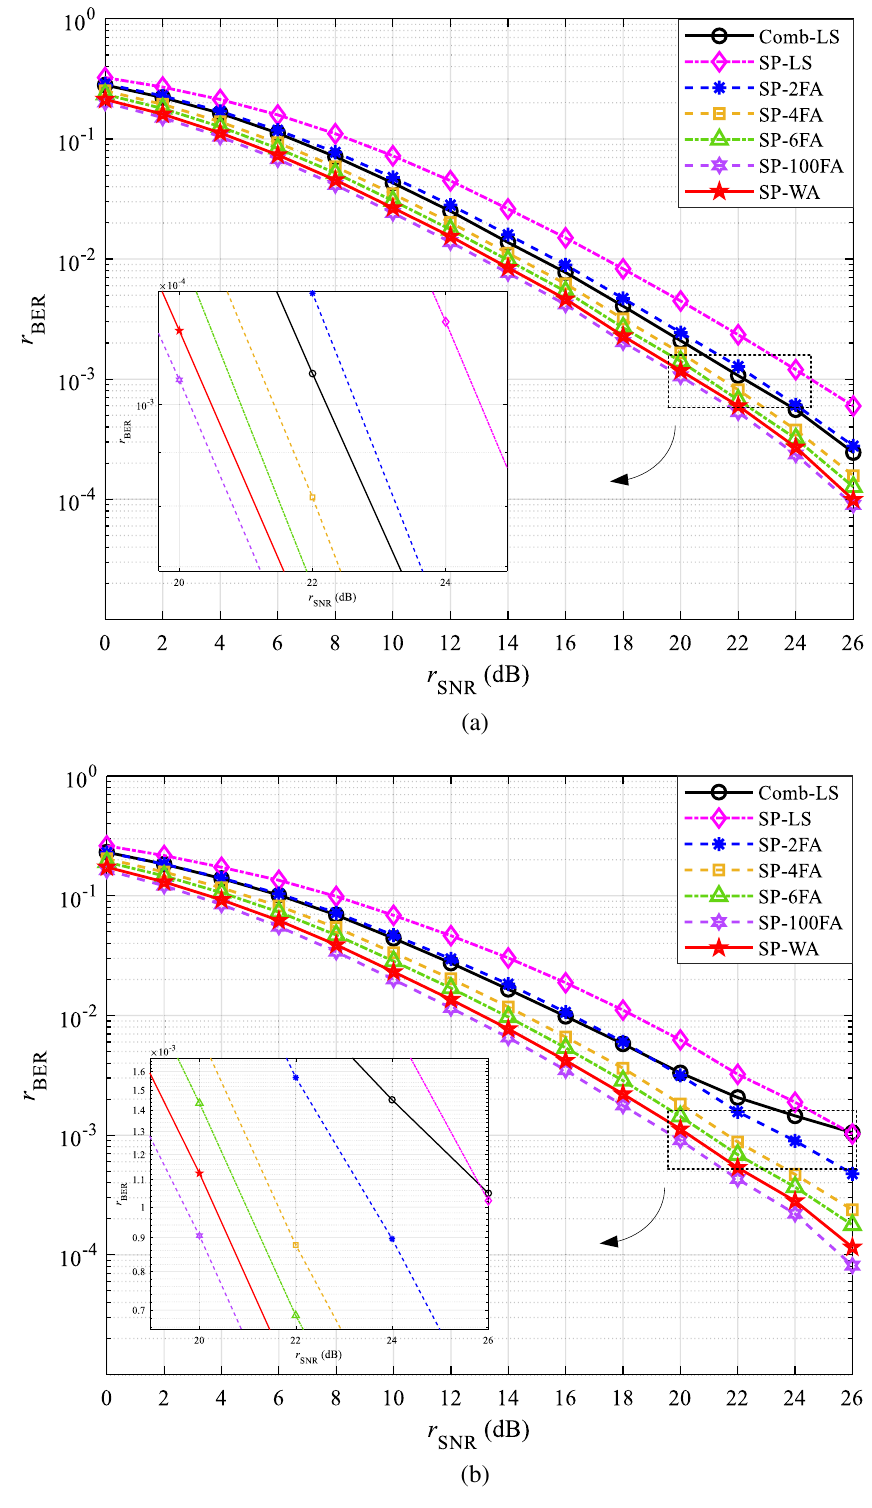
Figure 8. The BER performance in CDT 6 channel: ( a ) QPSK and ( b )